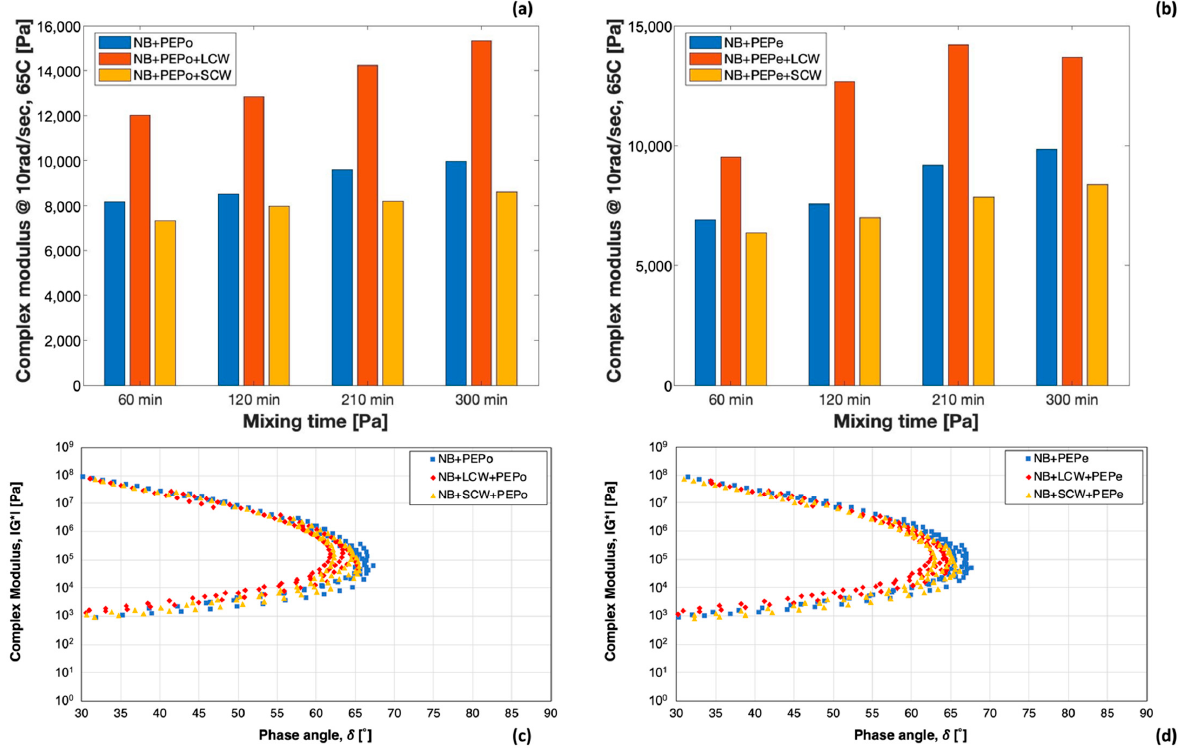
Figure 6. ( a , b ) Effect of the mixing time on the complex modulus at 65 °C and 10 rad/s and ( c , d ) impact of the modification on the ǀ G* ǀ - δ relationships.